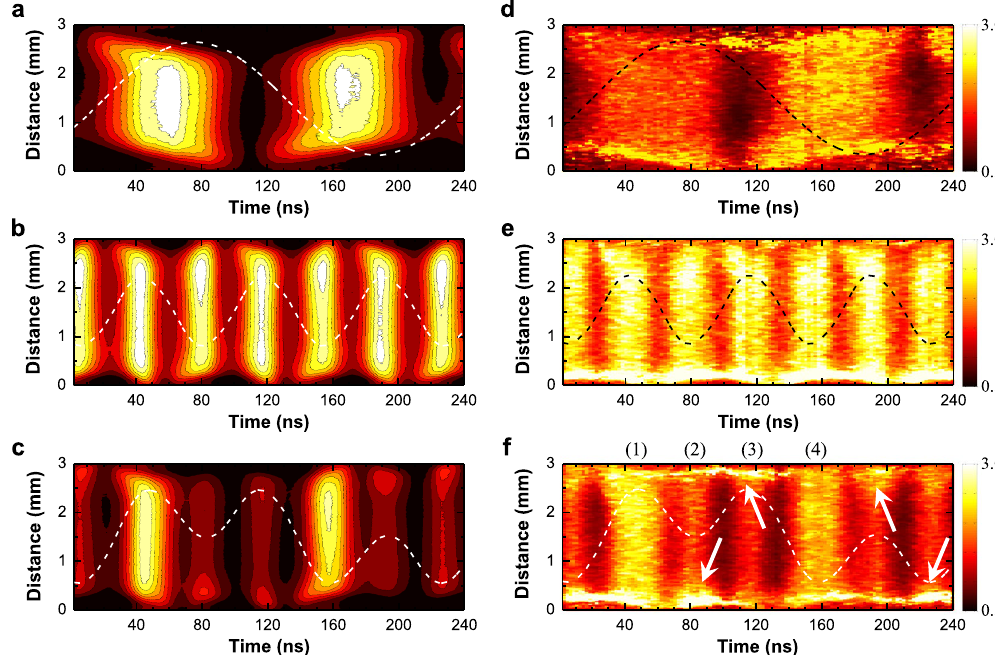
Figure 4. Nanosecond-resolved visualization of electron heating. Spatiotemporal evolution of neutral bremsstrahlung at 514.5 nm measured in a ( a ) 4.52-MHz single-frequency discharge, ( b ) 13.56-MHz single- frequency discharge, and ( c ) dual-frequency discharge, and spatiotemporal evolution of T e in a ( d ) 4.52-MHz single-frequency discharge, ( e ) 13.56-MHz single-frequency discharge, and ( f ) dual-frequency discharge. The dashed lines indicate the measured discharge voltage waveforms.